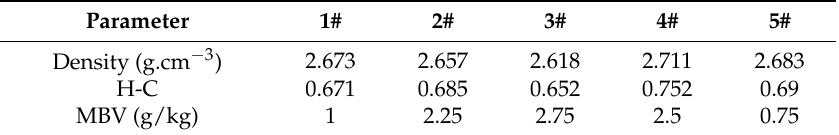
Table 5. Properties of the mineral